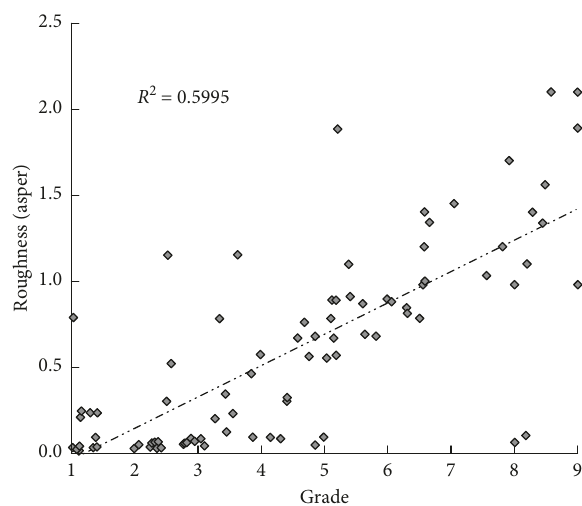
Figure 9: Correlation between roughness and evaluation